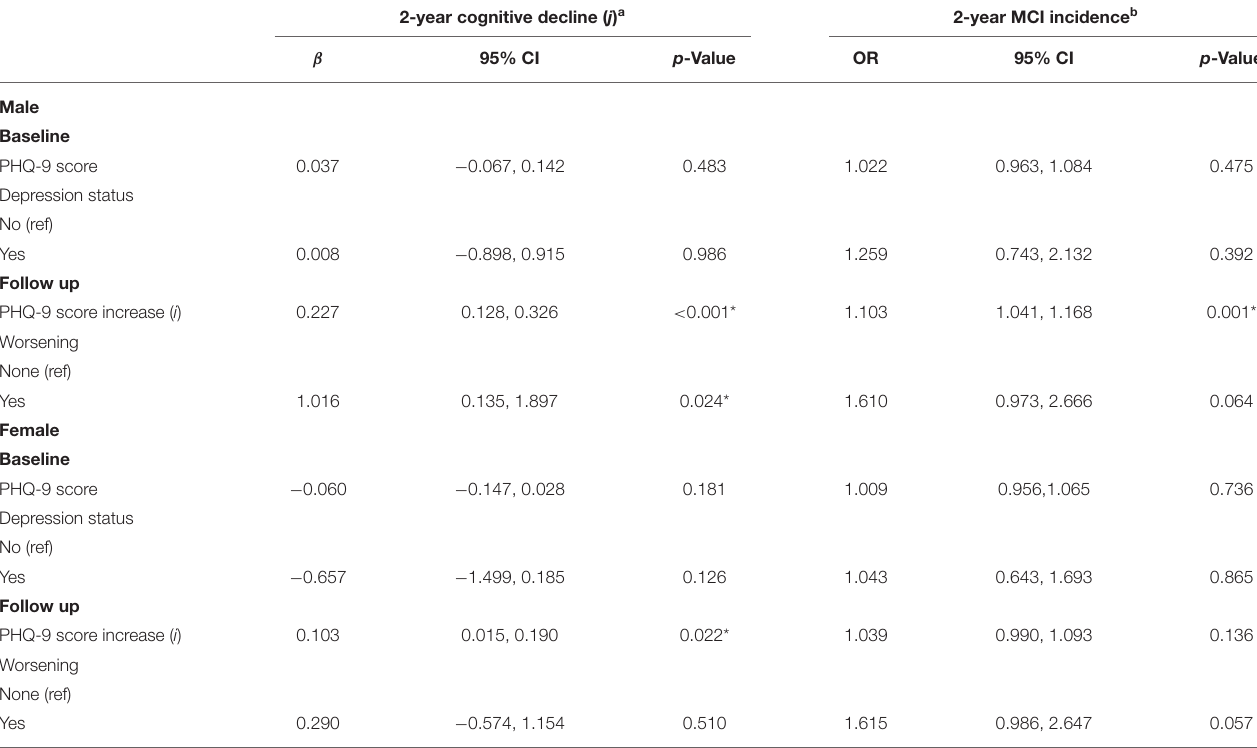
TABLE 3 | The associations between depression and cognitive function by sexes: Coefficients and 95% CIs for 2-year cognitive decline and Odds Ratios and 95% CIs for 2-year MCI